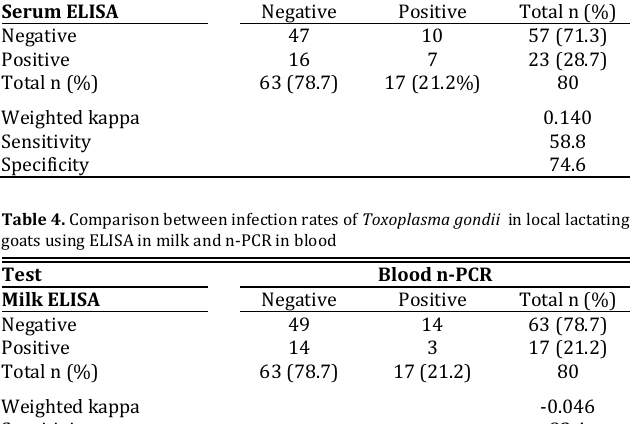
Table 2. Comparison between infection rates of Toxoplasma gondii in local lactating goats using n-PCR in milk and blood